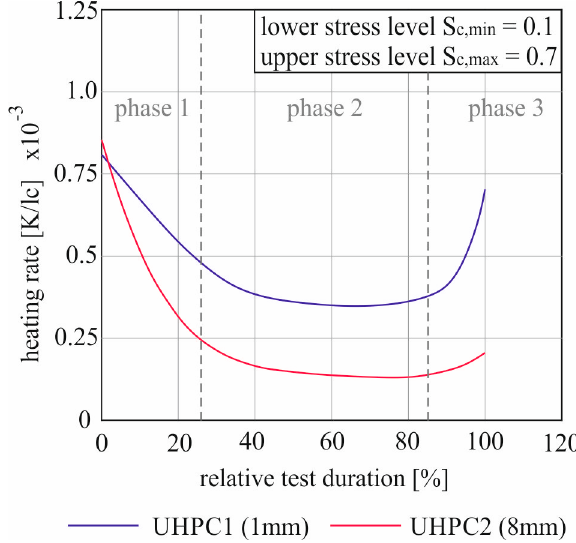
Figure 10. Comparison of the heating rate of UHPC 1 and UHPC 2 specimens for test frequency f P = f P = 10 Hz and relation between lower and upper stress level S c,min / S c,max = 0.1 / 0.7. The heating rate is 10 Hz and relation between lower and upper stress level S c,min /S c,max = 0.1/0.7. The heating rate is related related to the percentage test to the percentage test duration.